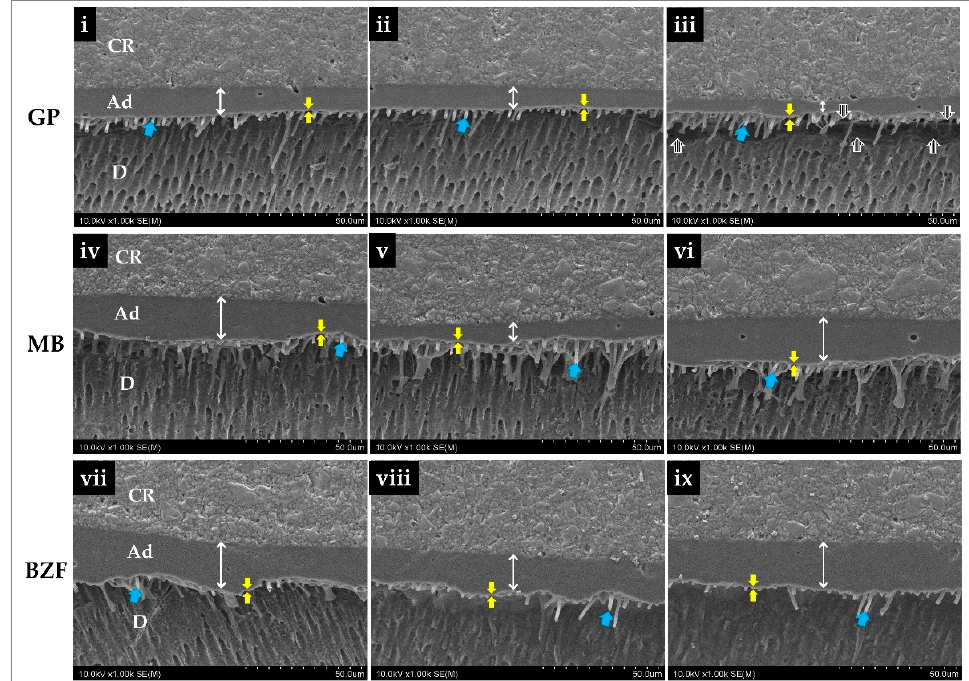
Figure 4. Representative SEM images of interfacial structures (1000×) of the tested adhesives—GP (G-Premio Bond), MB (Clearfil Megabond 2), and BZF (BZF-29). Double-ended white arrows represent the extension of the adhesive layers measured at left lateral ( i , iv , vii ), central ( ii , v , viii ), and right lateral ( iii , vi , ix ) spots of each bonded dentin slice. The electron-lucent area between the twin yellow arrows demarcates the hybrid layer. Blue arrows indicate resin tags. The striped arrows show gap formation at the resin ‐ dentin interface ( iii ). CR—composite resin; Ad—adhesive layer; D—dentin.